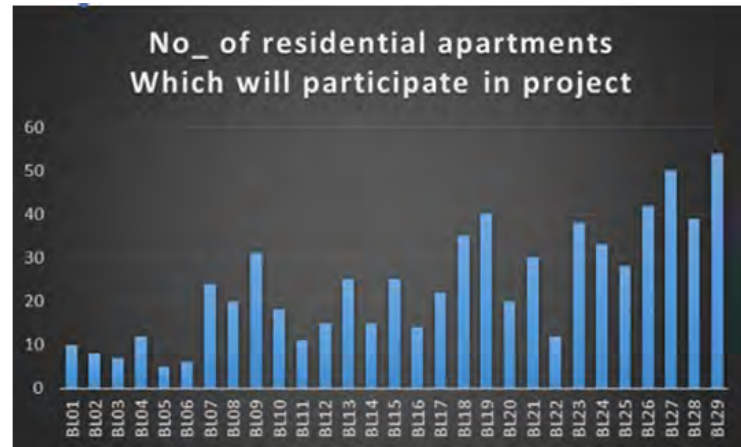
Figure 16. No of Residential Apartments which participate in